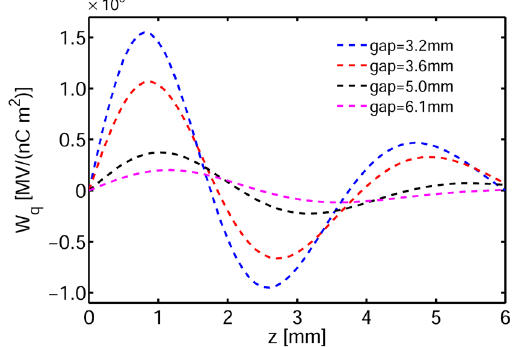
FIG. 3. The point charge quadrupole wake fields at various CS gaps respectively g ¼ 3 . 2 , 3.6, 5.0, 6.1